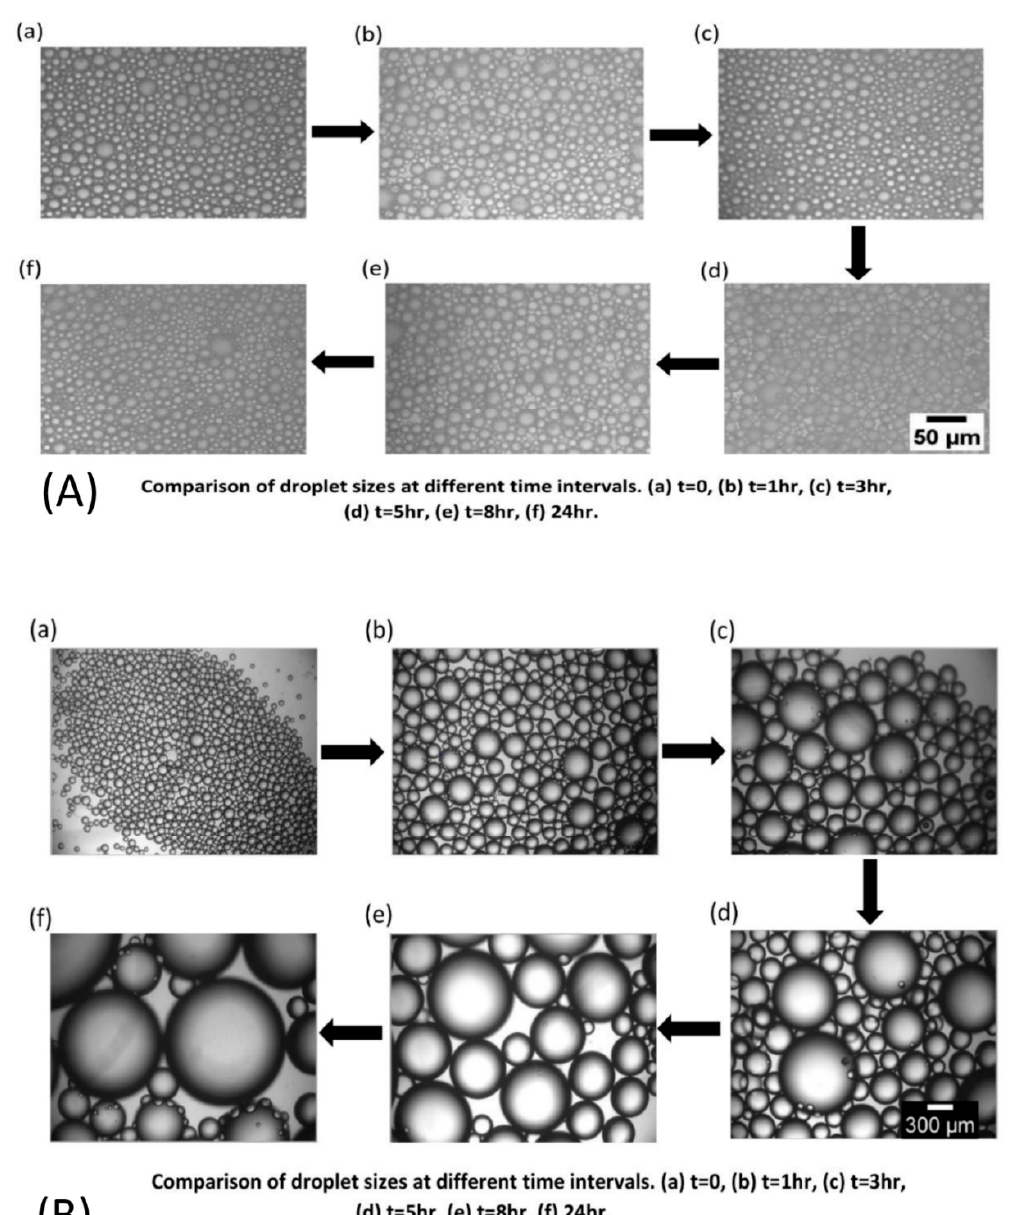
Figure 9. E ff ect of aging on the droplet size of ( A ) surfactant-stabilized and ( B ) nanoparticle-stabilized Figure 9. Effect of aging on the droplet size of ( A ) surfactant-stabilized and ( B ) O / W nanoparticle-stabilized O/W emulsion.